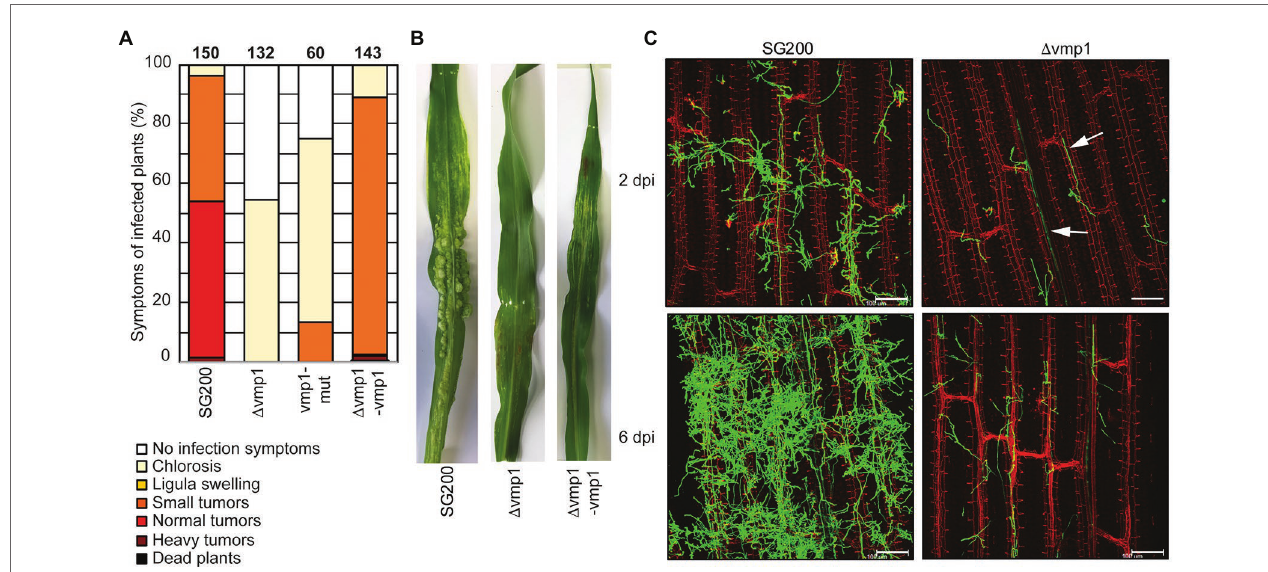
FIGURE 3 | Vmp1 is required for virulence (A) Virulence assay of the SG200 Δ vmp1 mutant strain deleted for the entire coding sequence of vmp1 , the SG200vmp1-mut strain that harbors a point mutation within the coding sequence of vmp1 and SG200 Δ vmp1-vmp1 complementation strain in an U. maydis SG200 background. The mean percentage of disease symptoms in the different categories is shown, which is quantified based on three biological replicates. The number of infected plants is indicated above the bars. (B) Macroscopic pictures of maize leaves 12 dpi with U. maydis SG200, SG200 Δ vmp1, and SG200 Δ vmp1- vmp1. (C) Leaf tissues infected with SG200 and SG200 Δ vmp1 were stained with WGA-AF488 and propidium iodide at 2 and 6 dpi. Green color indicates fungal hyphae and red color indicates leaf vascular bundles. Bar = 100 μ